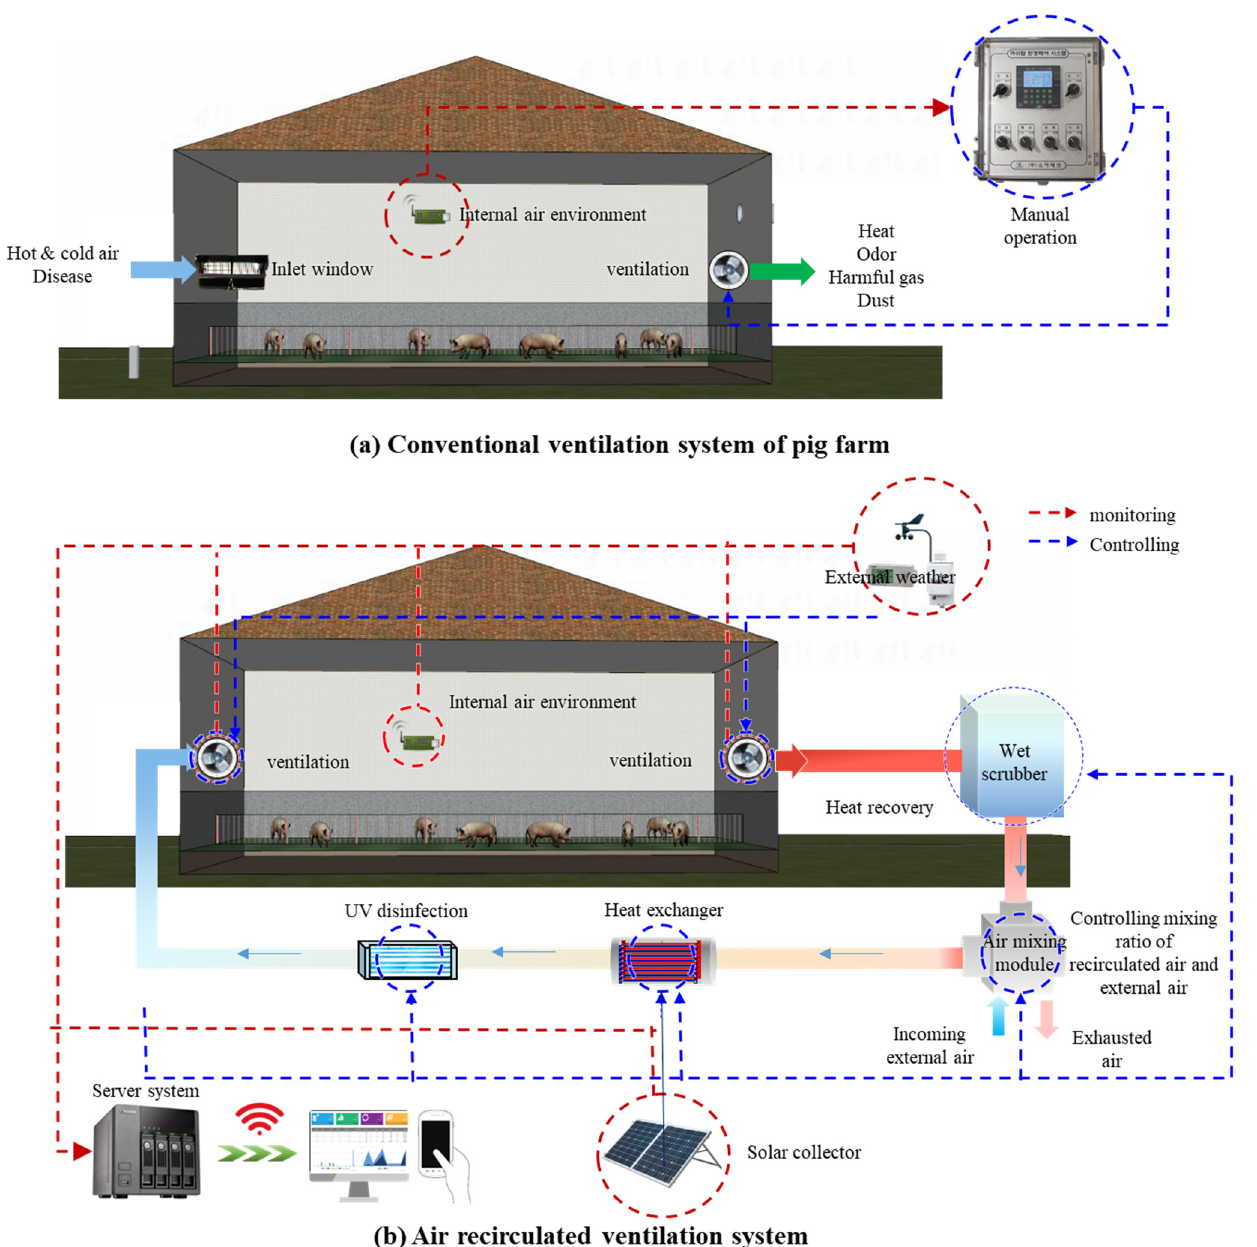
Figure 1. Schematic diagram of the conventional ventilation system and the developed air-recirculated ventilation system .